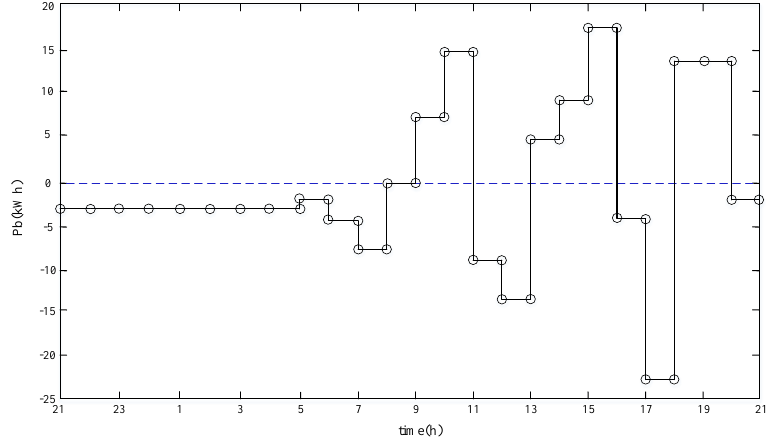
Figure 10. Output or input power of the battery. The SOC of the battery is shown in Figure 11.